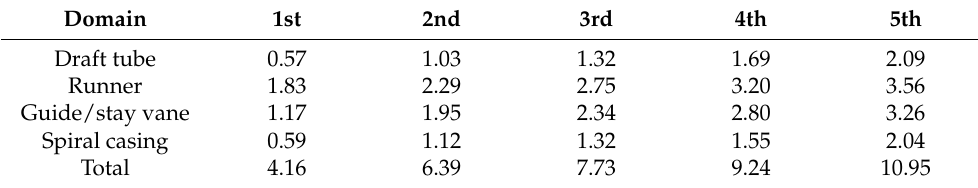
Figure 4. Grid independence at the best efficiency point of 13 mm GVO. Table 2. Detailed grid information (million).